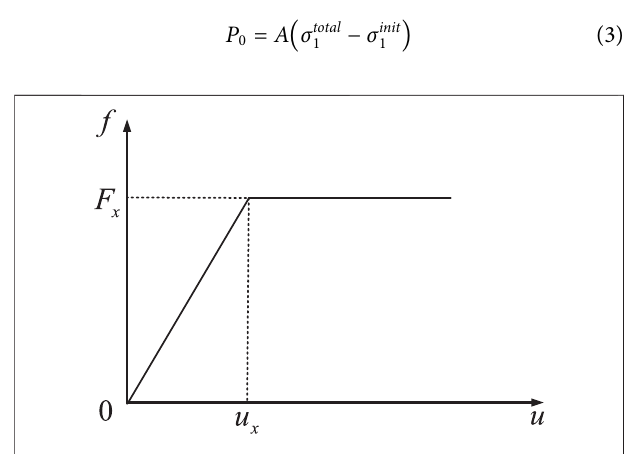
FIGURE2| Thepipe-soilinteractionmodel( f :thesoilfrictionofpipesper unit length; u: the relative longitudinal displacement between pipe and soil; F x : the ultimate soil resistance of pipes per unit length; k x : the longitudinal subgrade modulus of